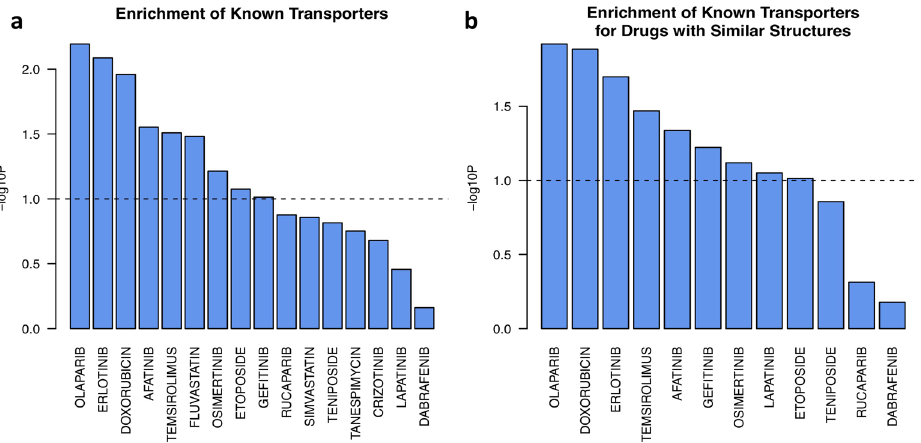
Figure 5. Enrichment of known transporters on the integrated list of all potential transporters sorted by their correlation with DiffSen. The predictive features are integrated across data sets for successful models of ( a ) the same drug, or ( b ) drugs with similar